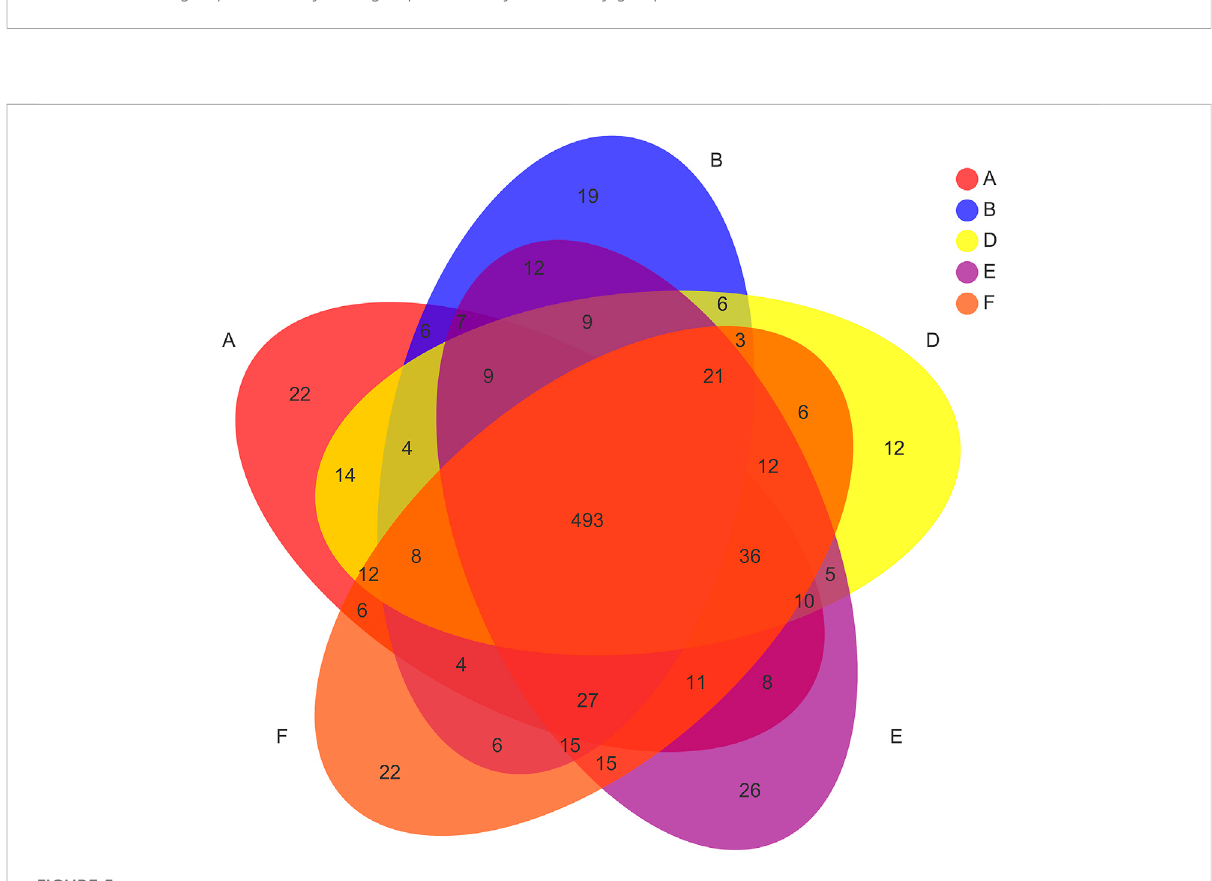
FIGURE 5 Veen plot of OUT distribution in different treatment groups. Note: A. Blank group B. DN model group C. Irbesartan group D. Cornus of fi cinalis group E. Wine Cornus of fi cinalis group F. Wine honey Cornus of fi cinalis group G. Auxiliary wine group H. Auxiliary wine honey group.